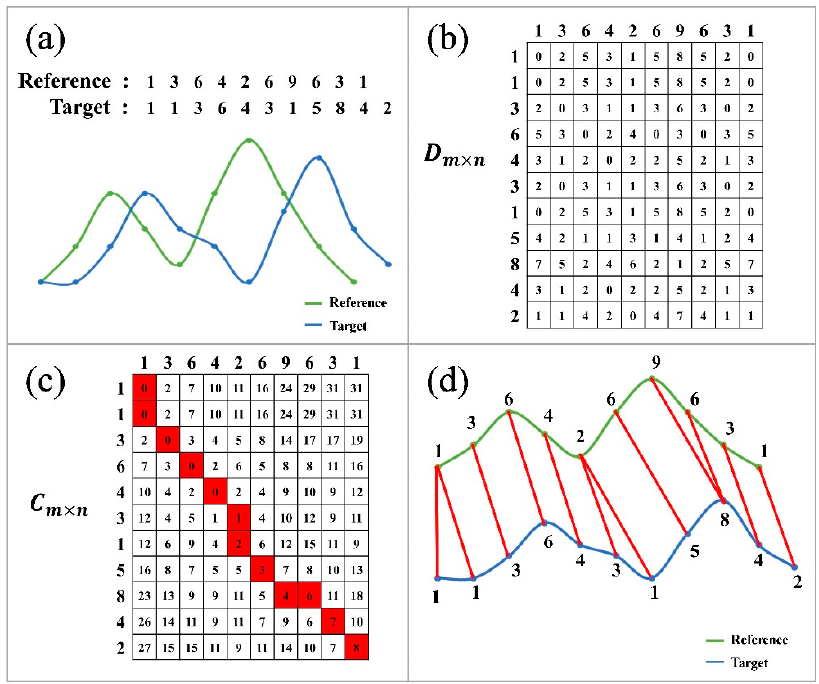
Figure 3. An illustration of the TWDTW algorithm. ( a ) The reference curve (green) and the target curve (blue). ( b ) The distance matrix D m × n between the reference curve and the target curve. Here, to simplify the calculation, w i , j was set to 1. ( c ) The cumulative distance matrix D m × n between the reference curve and the target curve and the warping path (red boxes) computed by the TWDTW algorithm. ( d ) The time alignment relationship (red line segments) between the reference curve and the target curve.